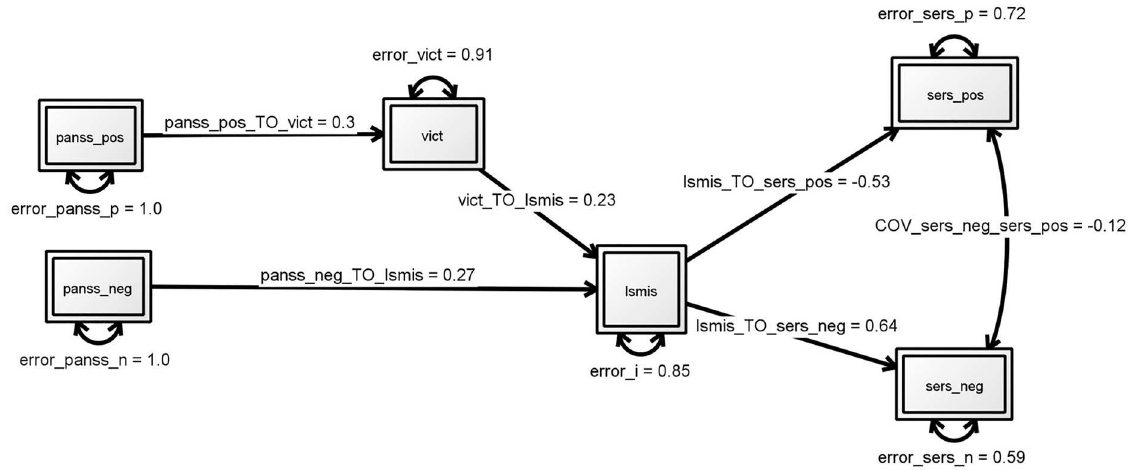
Fig 3. Third model: victimization mediating effects positive symptoms on self-stigma, direct effect negative symptoms on self-stigma. Structural equation modeling.Numbers by single-headedarrows reflect standardized regressionweights. Fit indices: χ 2 = 7.674; df = 8; p = .4659, RMSEA (90%CI) = .000 (0-.113), SRMR = .0059, CFI = 1.000, TLI = 1.005, Akaike (AIC) 3610.505. * p < 0.05, ** p < 0.01. PANSS_pos:level of positive symptoms on PANSS, PANSS_neg: evel of negative symptoms. ISMIS: total score on four subscales of the Internalized Stigma of Mental Illness Scale (alienation, stereotype endorsement, perceiveddiscrimination, social withdrawal) indicatinglevel of self-stigma. SERS_pos:score on subscale positive self-esteem of the Self-Esteem Rating Scale-Short Form and SERS-neg:score on the subscale negative